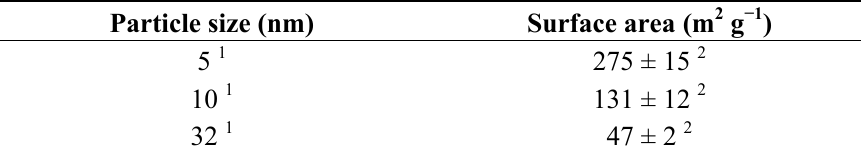
catalyst surface area. 2